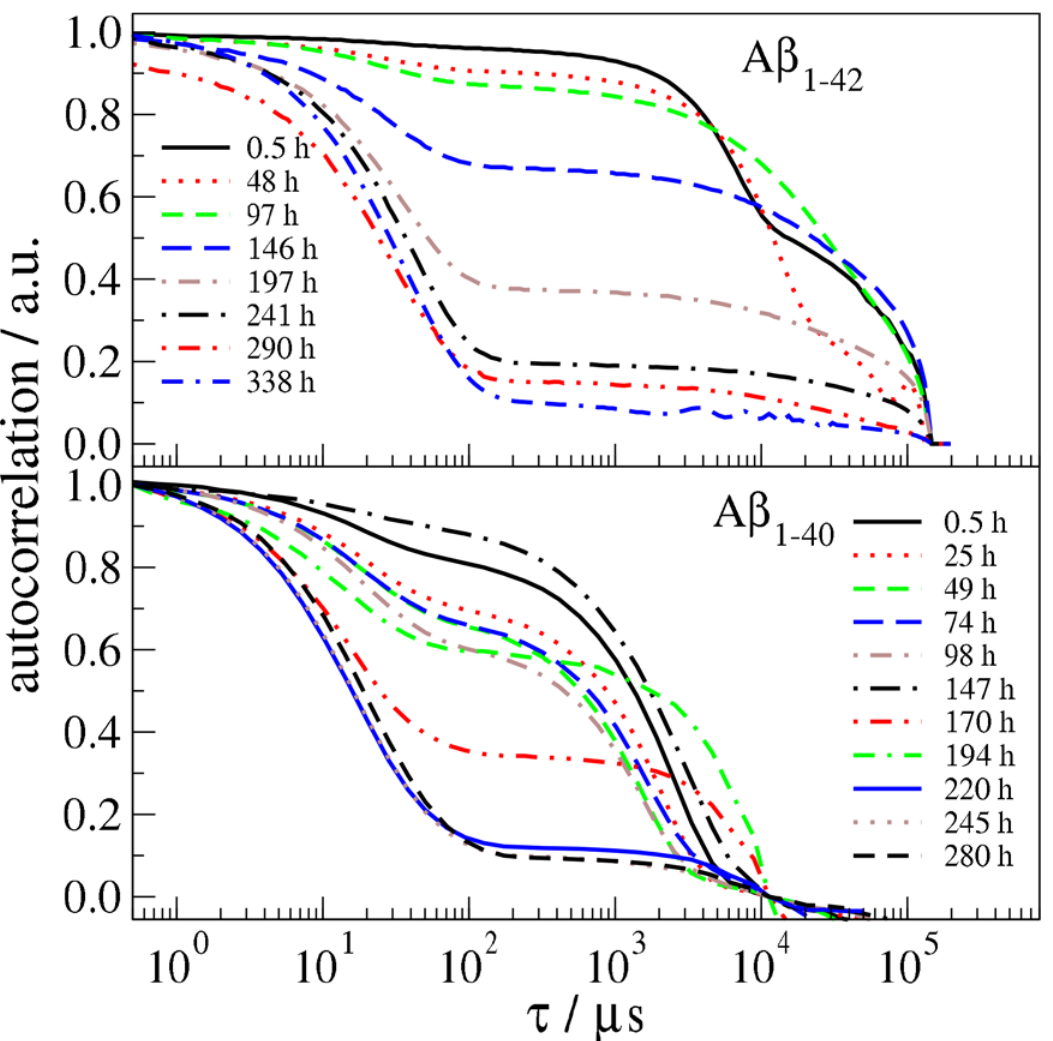
Fig 1. Time resolved DLS experiment of A β 1 – 42 and A β 1 – 40 in dHFIP. The samples were measured between 0.5 h and 14 days after initial incubation at 20°C. For A β 1 – 40 the value of τ = 10000 μ s is subtracted to focus on the two smaller species. For both samples correlations are normalized to 1 for τ ! 0 to get a better overview over the data. Original measurements are found in S1 and S2